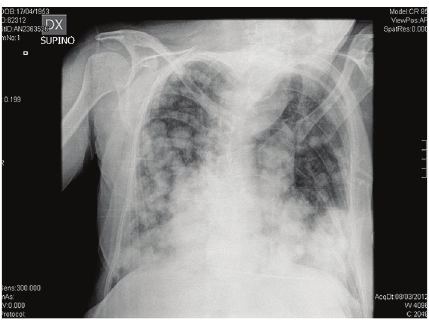
Figure 2: Hypoechoic mass involving tricuspid annulus. Echocar- diography apical four chambers view showing a hypoechoic mass involvingtricuspidannulusandrightventricleoutflowtract(arrow).